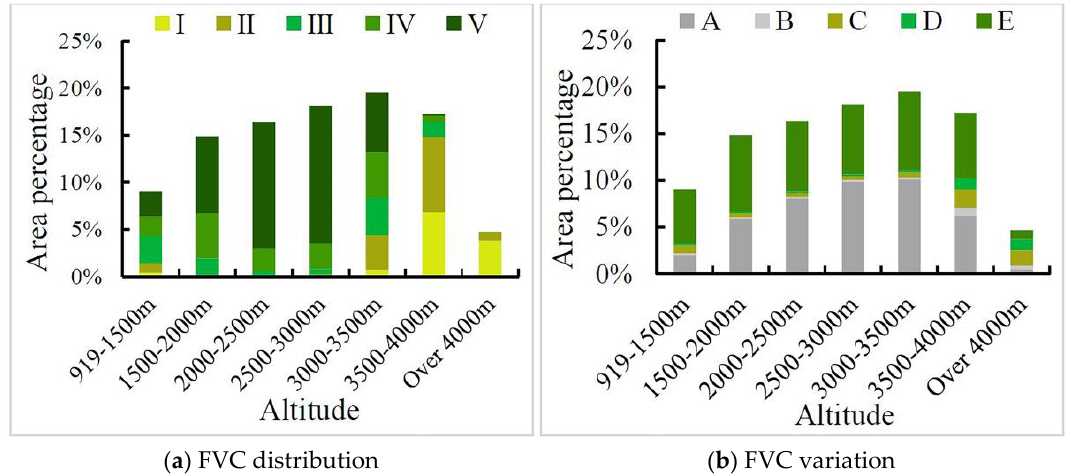
Figure 10. Distribution ( a ) and variation ( b ) of FVC at different altitudes.